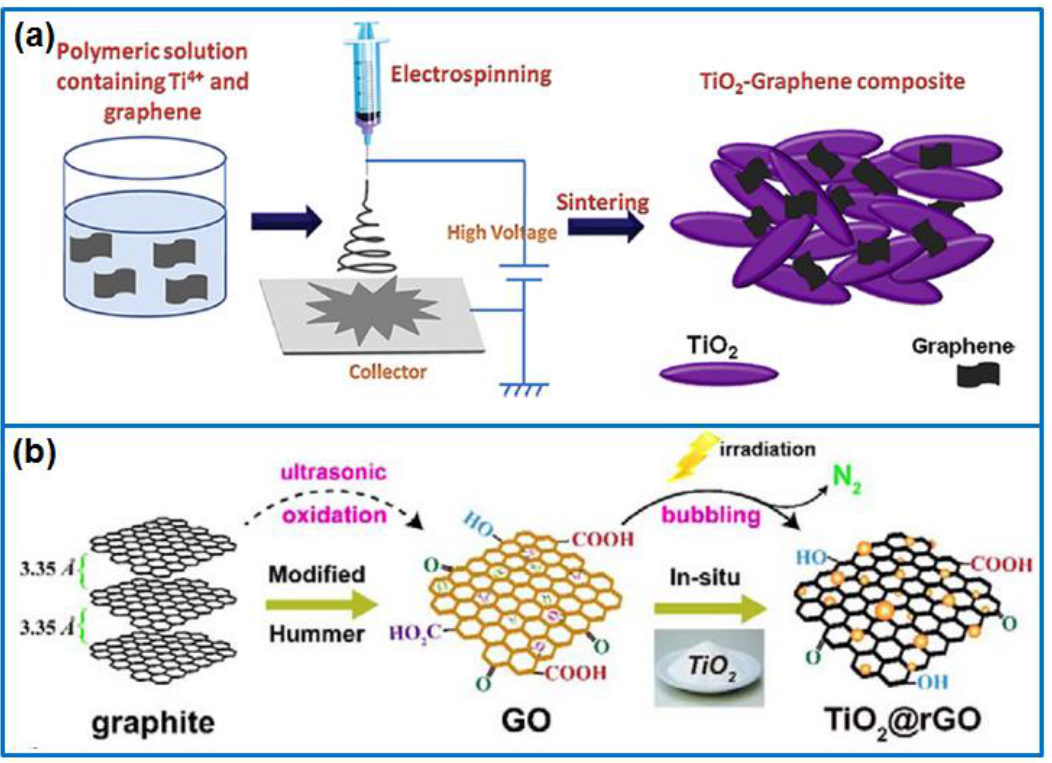
Figure 2. ( a ) The rice-shaped TiO 2 –graphene composite prepared by electrospinning; produced with